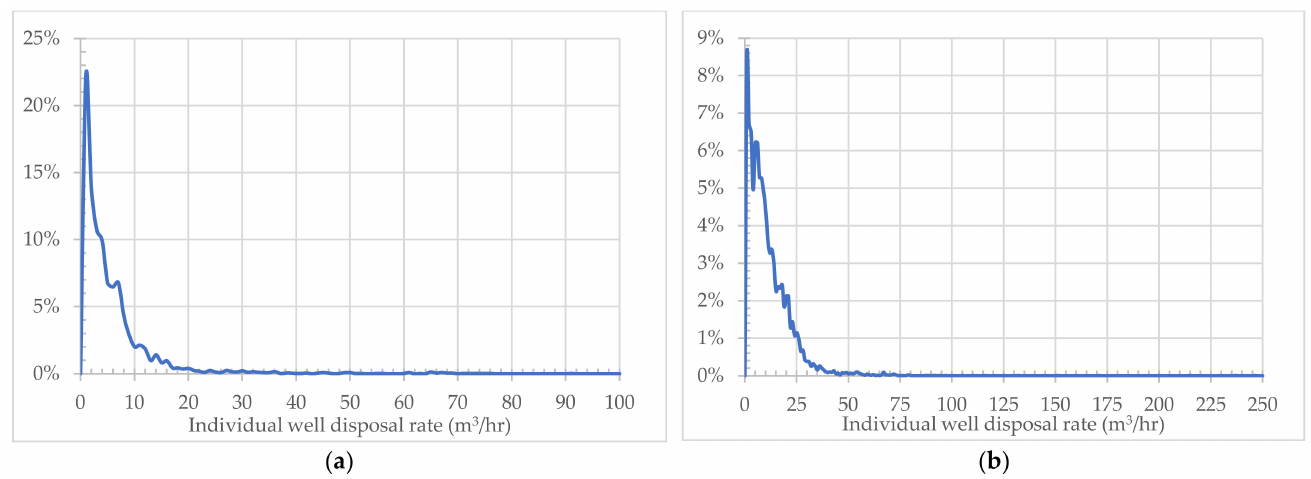
Figure A20. Historical per-well water injection rate ( X -axis) frequency ( Y -axis) distributions (January 1962–December 2022) in ( a ) the Montney Formation; ( b ) the Belloy Formation.